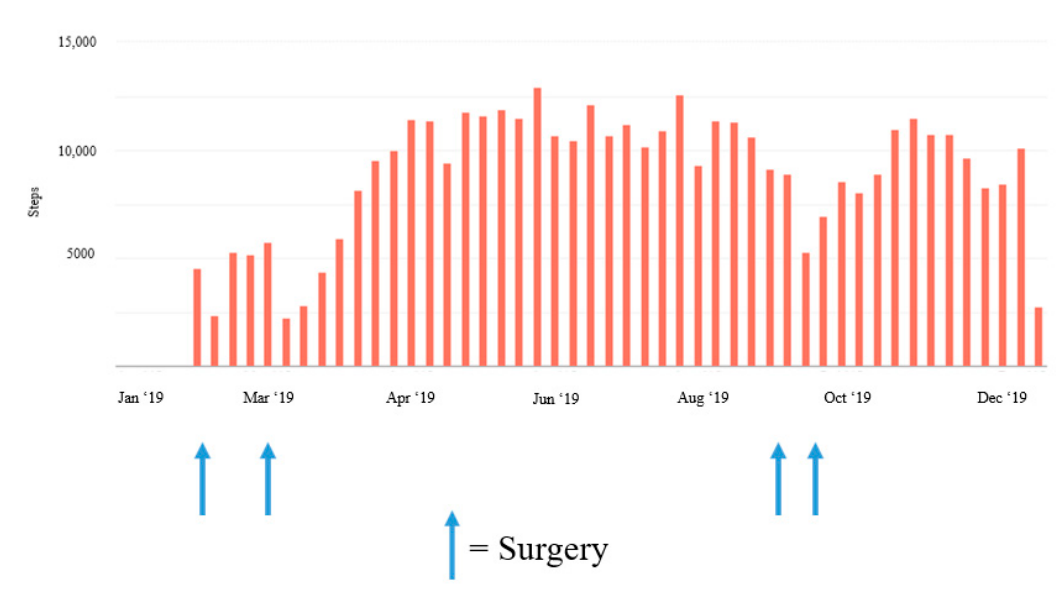
Figure 3. Weekly changes in step activity during 2019 pre- and post-operation.